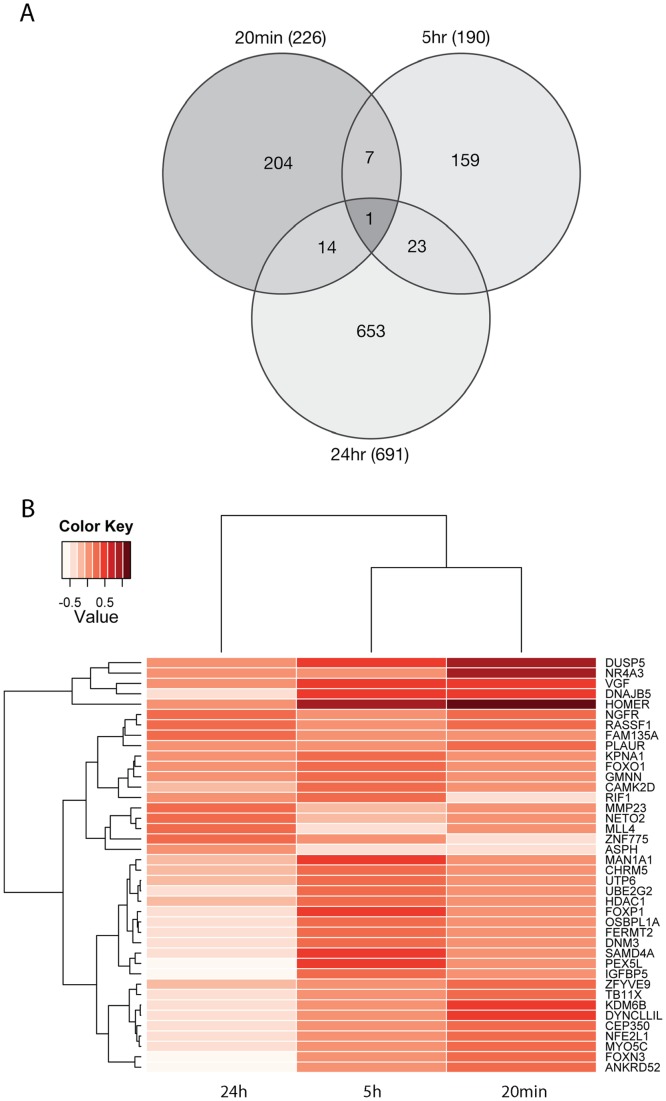
Temporal relationship of LTP-regulated datasets.(A) Venn Diagram showing 3 datasets largely contain temporally specific genes. (B) Heatmap displaying average gene expression values (expressed as log fold change) of overlapping genes across the timepoints.